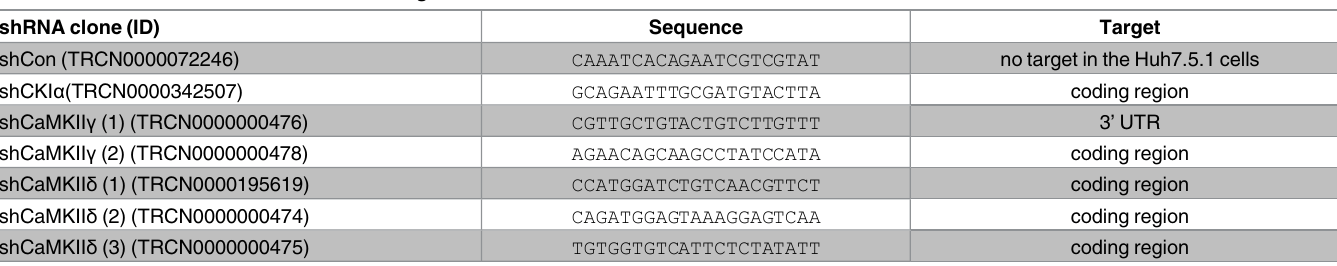
Table 3. Plasmids used for shRNA-mediated gene